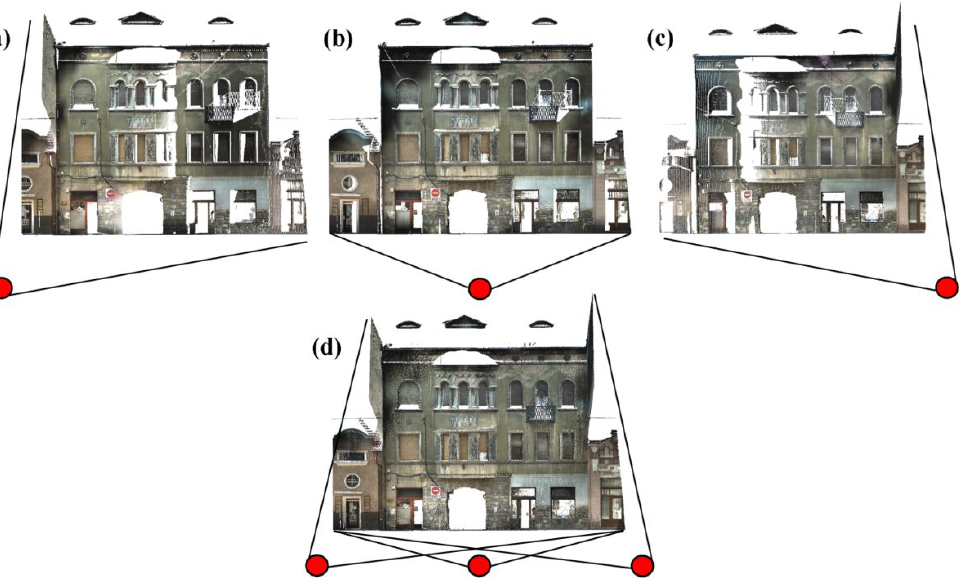
Figure 4. Presentation of point clouds resulting from terrestrial laser scanning ( TLS ) (( a ) scan position 1—left; ( b ) scan position 2—center; ( c ) scan position 3—right; ( d ) results of interconnection of point clouds obtained from the three scan positions).